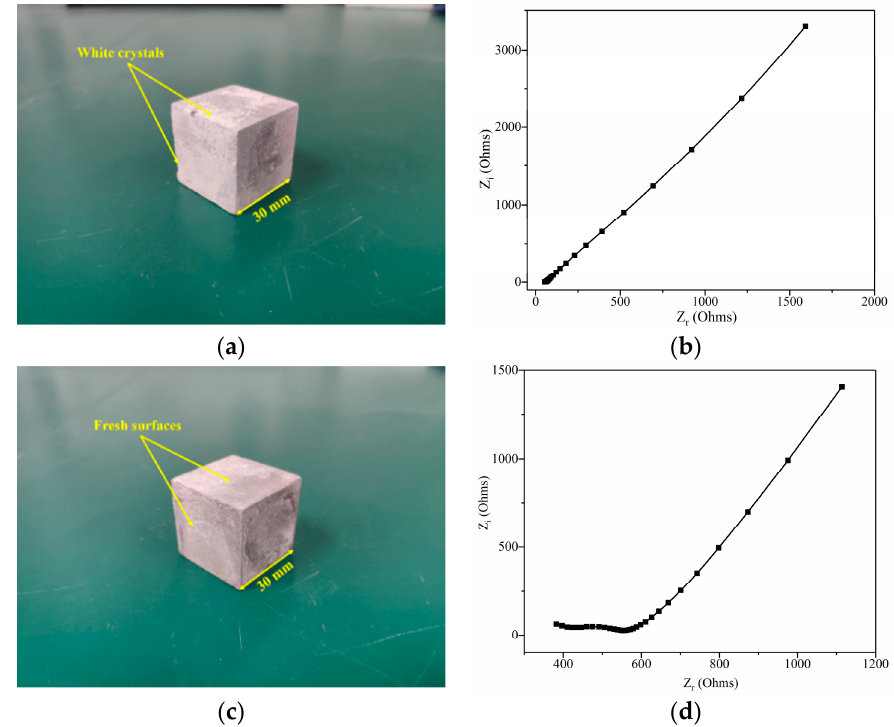
Figure 3. Morphology and the Nyquist curve of G1 after leaching for 7 days: ( a ) morphology of G1 before immersion; ( b ) the Nyquist curve of G1 before immersion; ( c ) morphology of G1 after immersion; and ( d ) the Nyquist curve of G1 after immersion.